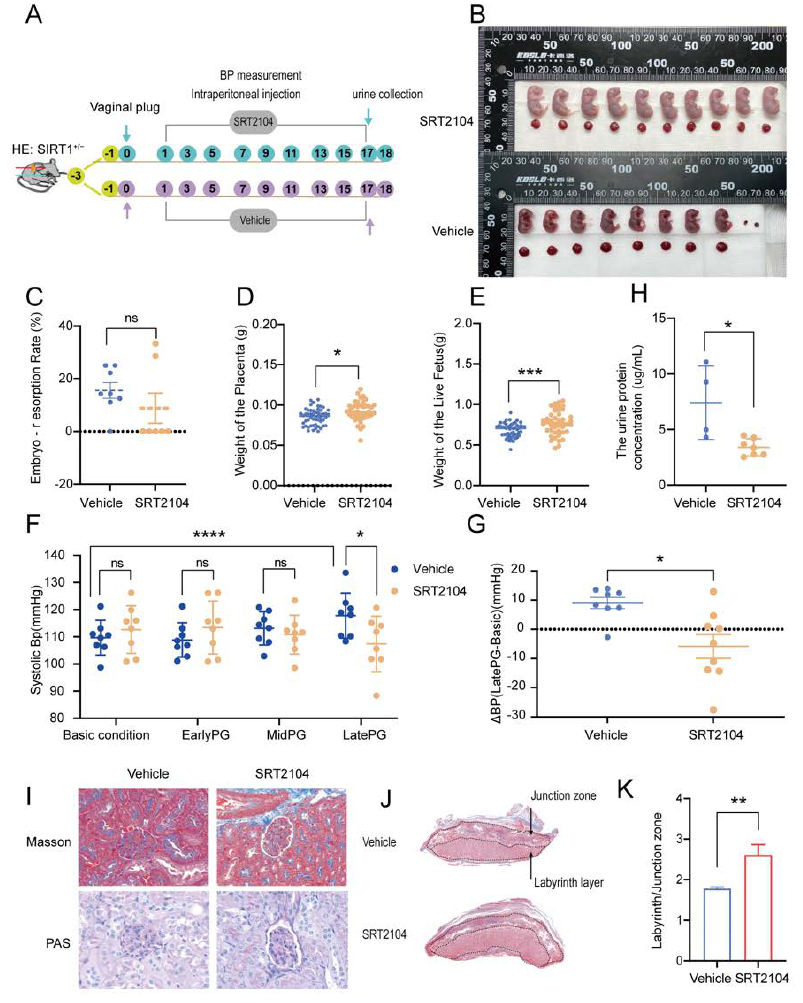
Figure 3. SRT2104 significantly improved the PE-like symptoms in SIRT1 +/ − mice. ( A ) Schematic diagram of the treatment of SIRT1 +/ − mice from early pregnancy to late pregnancy. ( B ) Representative appearance of fetuses and placentas from vehicle and SRT2104 groups. ( C – G ) The embryo-resorption rate ( C ), the weight of the placenta ( D ), and the weight of the live fetus ( E ) in vehicle ( n = 8) and SRT2104 ( n = 7) groups. ( F ) The SBP at basic condition, early PG, and mid PG, late PG from vehicle ( n = 8) and SRT2104 ( n = 9) groups. ( G ) ∆ BP (late PG—basic condition) in vehicle ( n = 8) and SRT2104 ( n = 9) groups. ( H ) The concentration of urinary protein in vehicle ( n = 4) and SRT2104 ( n = 7) group at late PG. ( I ) Masson staining and PAS staining of mice kidney tissues from vehicle ( n = 4) and SRT2104 ( n = 4) groups. ( J ) Masson staining of mice placental tissues in vehicle ( n = 4) and SRT2104 ( n = 4) groups. ( K ) The labyrinth/junctional zone ratio of each group. Error bars, mean ± SD. The data were analyzed by one-way ANOVA (and nonparametric or mixed) and unpaired Student’s test (and nonparametric tests). * p < 0.05; ** p < 0.01; *** p < 0.001; **** p < 0.0001, ns: no significance.